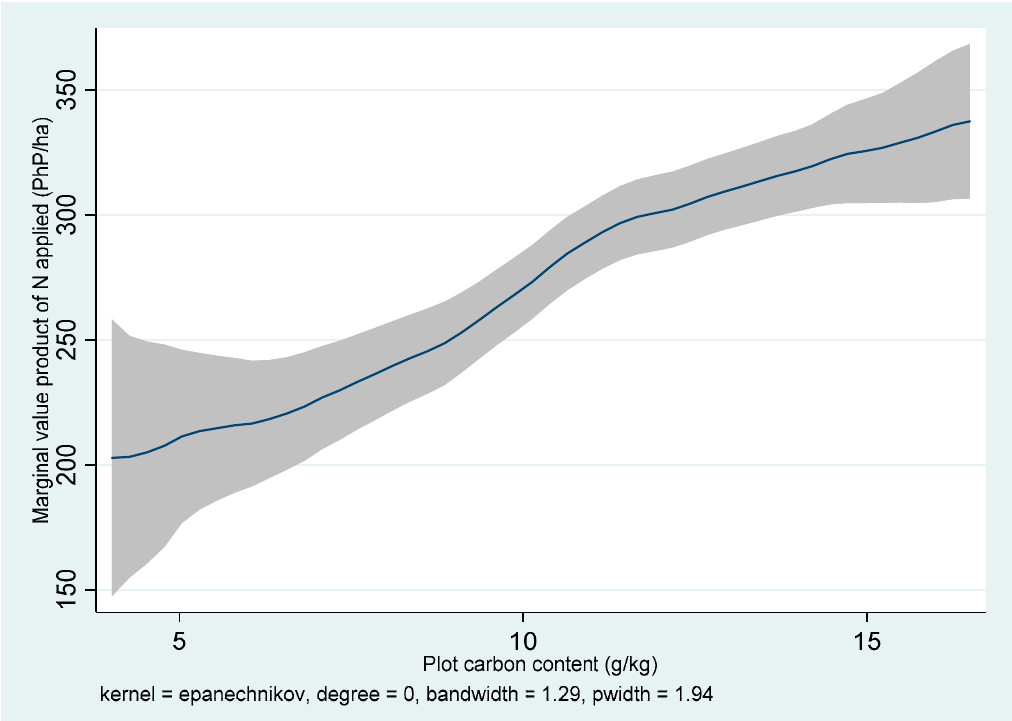
Figure 11. Marginal value product of N ( MVP N ) based on the plot’s carbon content in Nueva Ecija, Philippines.